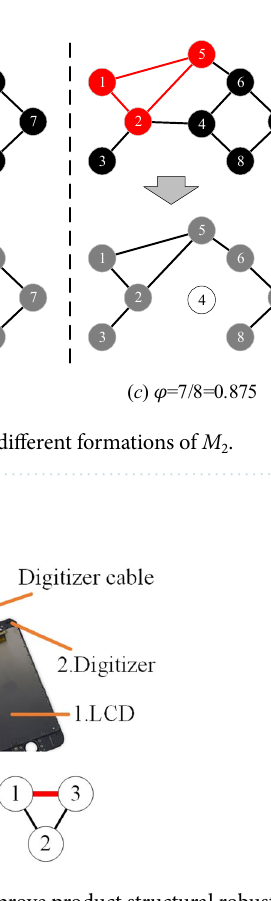
Figure 14. Reduce the frequency of M 1 to improve product structural robustness. (Adapted in part with free permission from iFixit, https:// www. ifixit. com/ Teard own/ iPhone/. Licenced under the CC BY open access